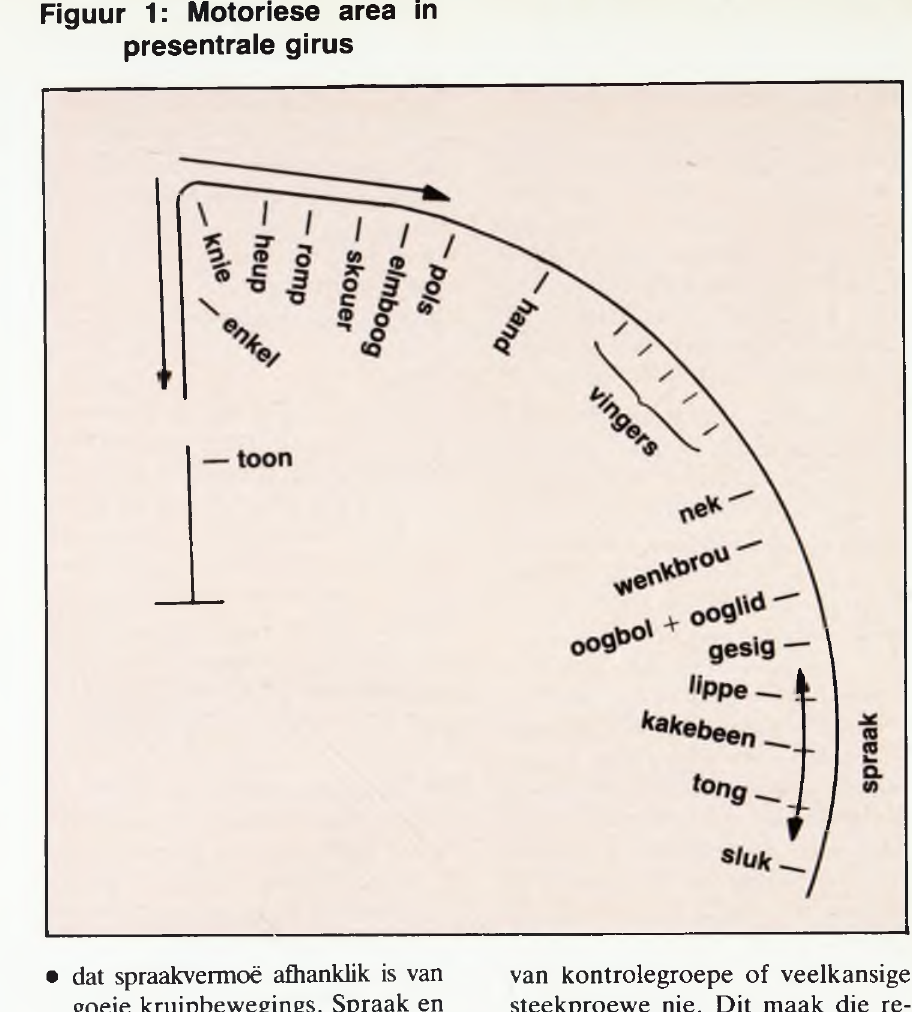
Figuur 1: Motoriese area in presentrale